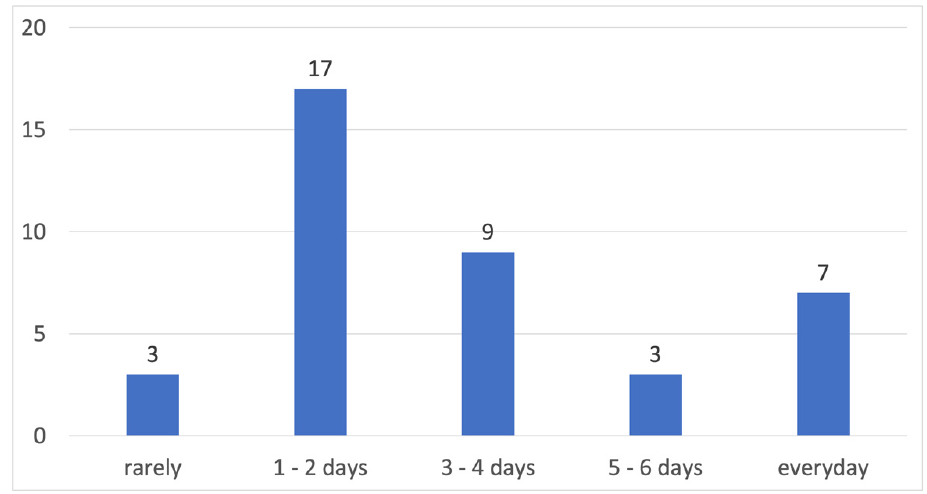
Figure 2. Answers to “how many days do you use SVOD services in a week?”.